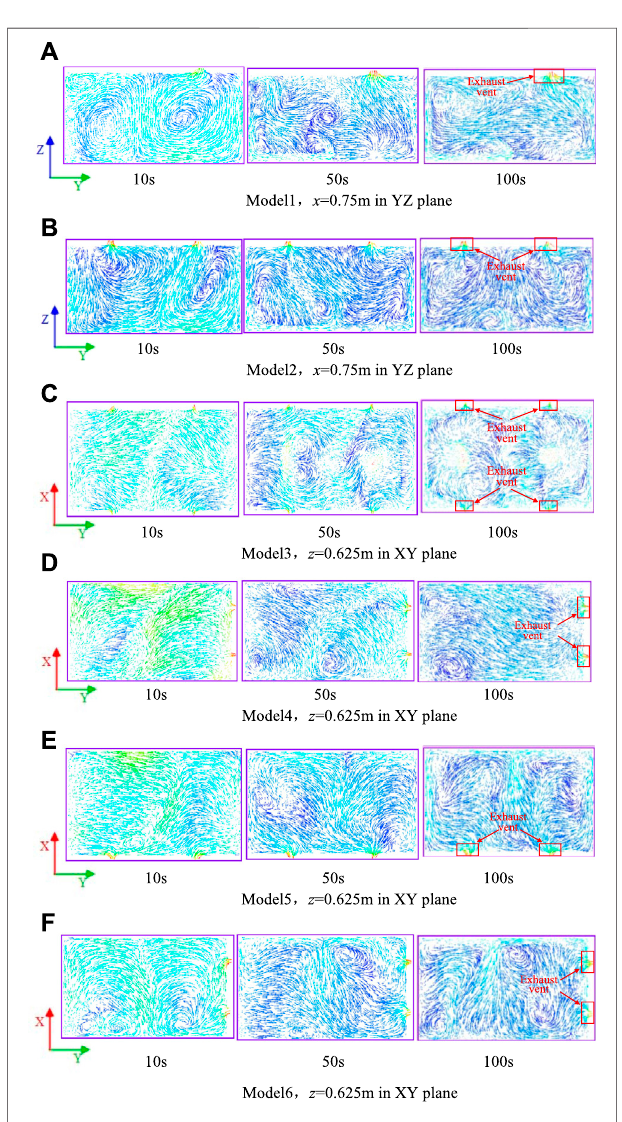
FIGURE 6 | Tritium gas fl ow velocity vector, m · s − 1 .